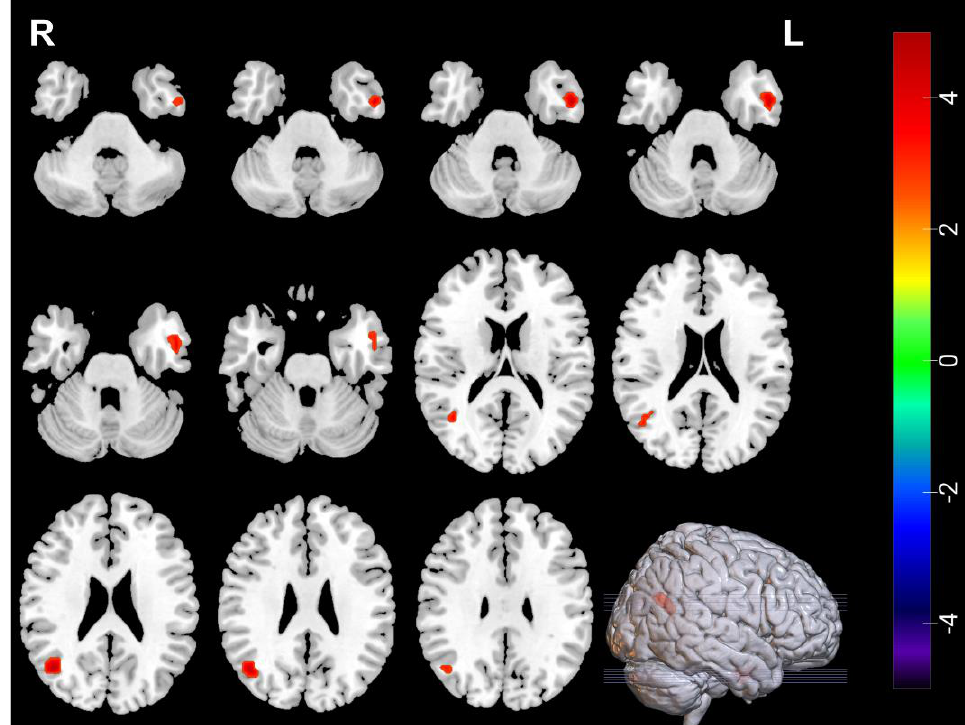
Figure 4. The red regions represent increased ReHo in Temporal_Inf_L and Occipital_Mid_R in MDDs after ECT. ReHo voxel p < 0.005; GRF correction p < 0.05; cluster size > 34.